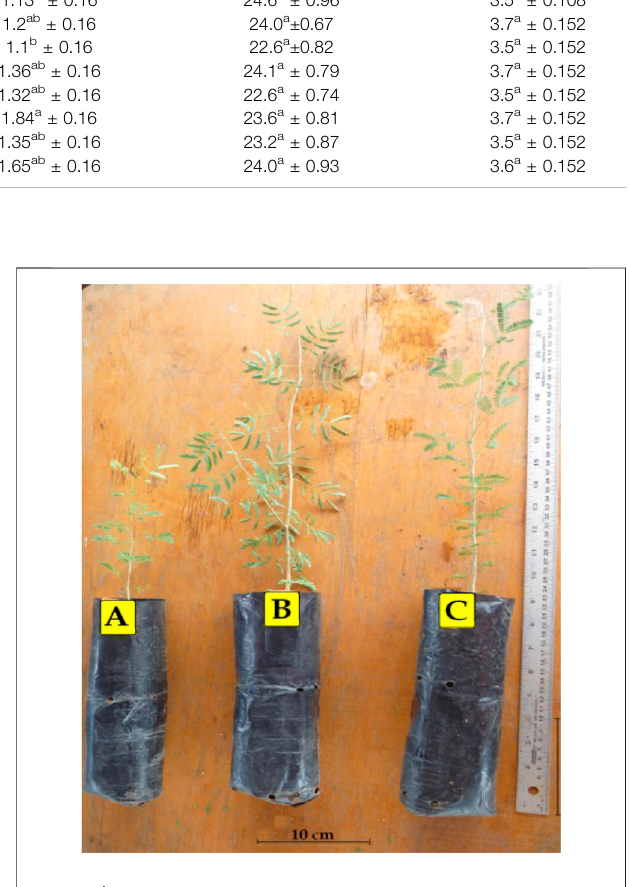
FIGURE | PHOTO 1: View of S. senegal plants 75 days after sowing in nursery conditions. Note the difference in height between substrates A, B and